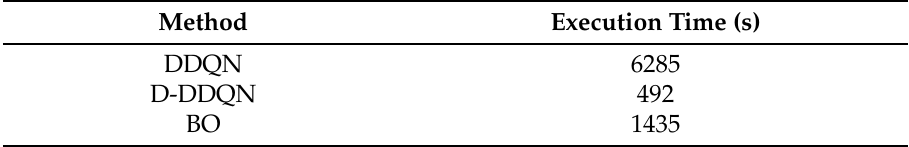
Table 6. Execution time for different optimization